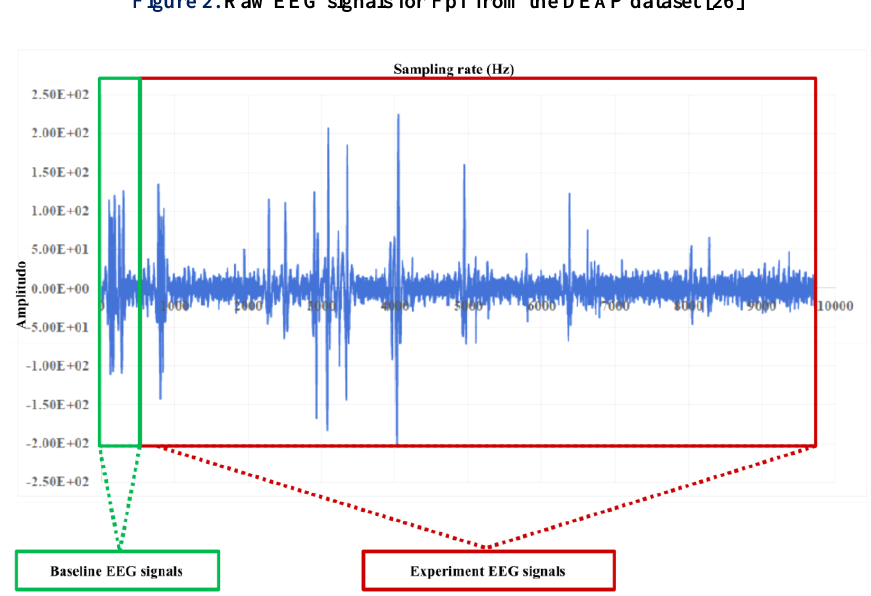
Figure 3. Raw EEG signals for AF3 from the AMIGOS data set [27]